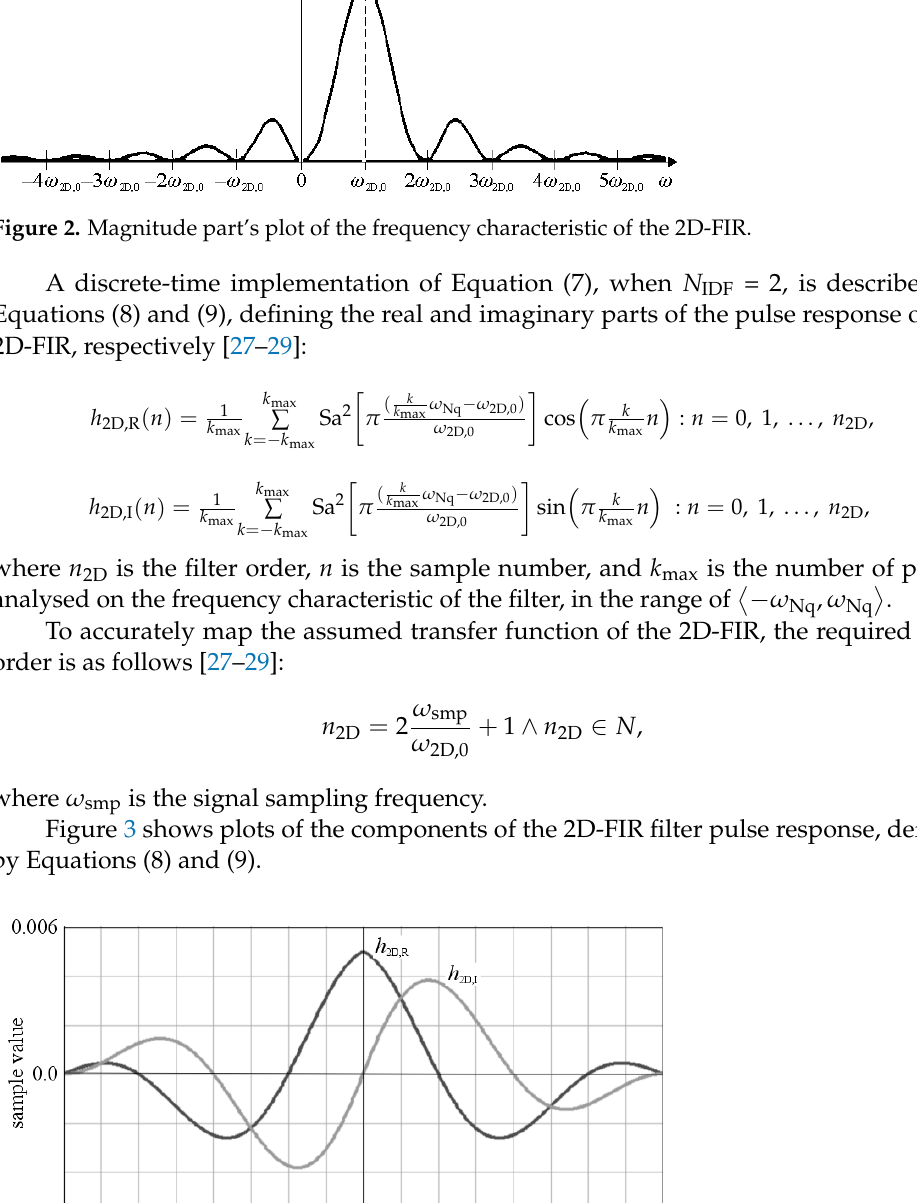
Figure 4. Block diagram of the identification algorithm. The algorithm consists of the following functional blocks: •